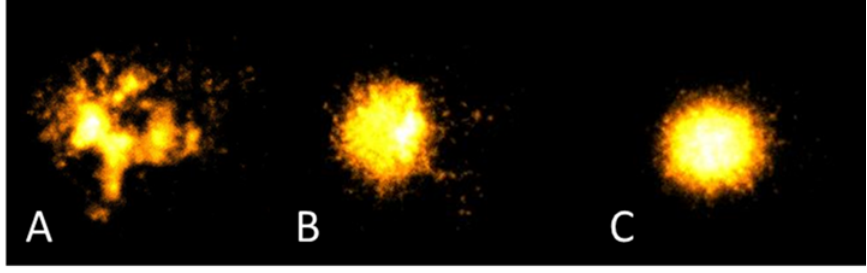
Figure 3. Representative images of different levels of DNA damage as measured by the Comet assay. A : extensive damage; B : moderate damage; C : minor